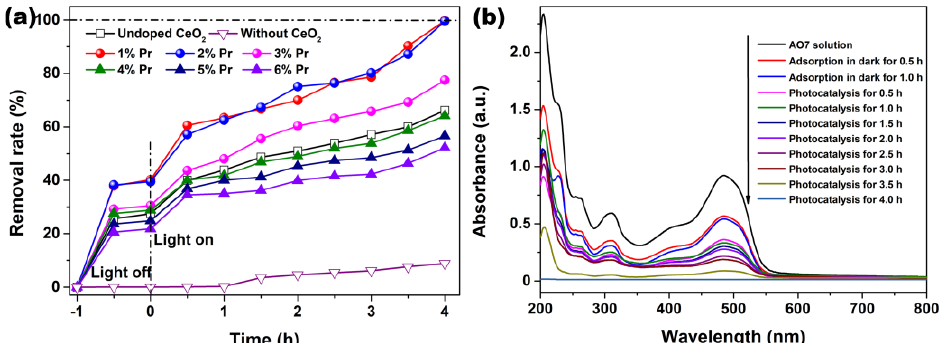
Figure 8. ( a ) AO7 adsorption in dark and photocatalytic degradation upon illumination using an ultraviolet lamp (300 W; λ = 254 nm) in the presence of Undoped CeO 2 and Pr-doped CeO 2 with different Pr concentrations, ( b ) UV-VIS absorption spectra of AO7 removal by 1% Pr-doped CeO 2 . ([AO7] = 20 mg/L; [CeO 2 ] = 1.0 g/L; V = 100 mL; Room temperature; Without pH